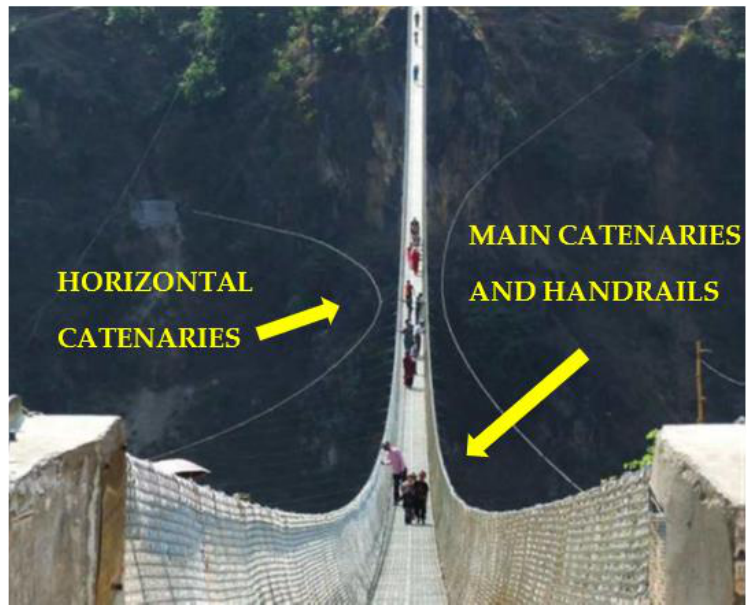
Figure 1. The Kushuma Gyadi (Nepal) suspended bridge (photo by Basu Dahal, [12]).